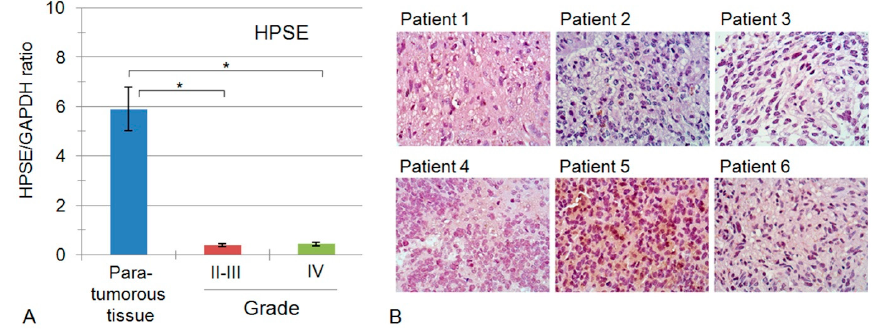
Figure 3. HPSE expression in the human brain tumours. ( A ) HPSE mRNA expression levels in tumour samples (real-time RT-PCR). The intensity of the amplified DNA fragments was normalised to that of GAPDH . Bars represent the mean from triplicate experiments ± SD (Origin 8.5; OriginLab with Hematoxylin; 1–6 patients; magnification × 400.